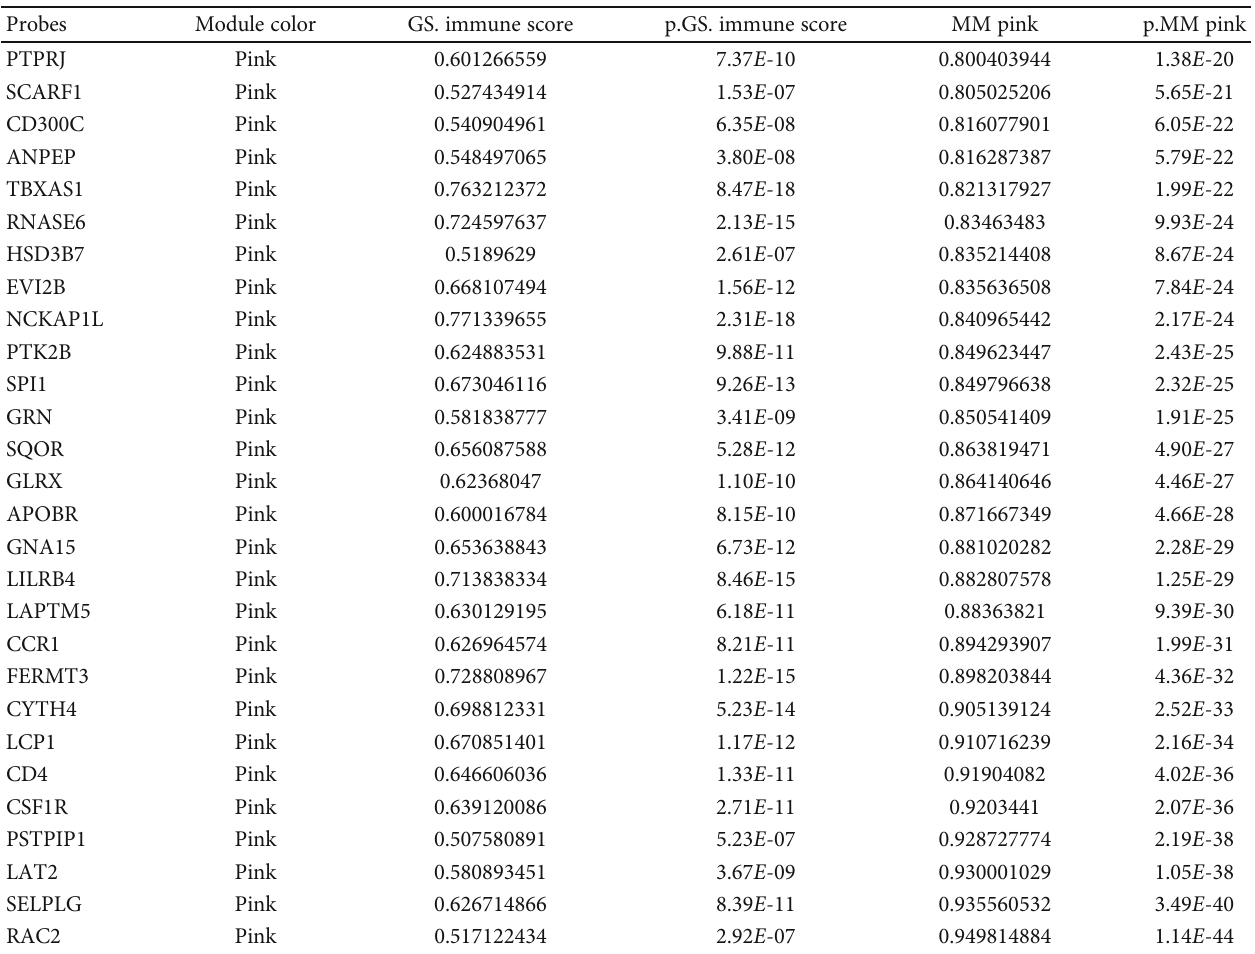
Table 1: 28 key genes selected in the pink module.